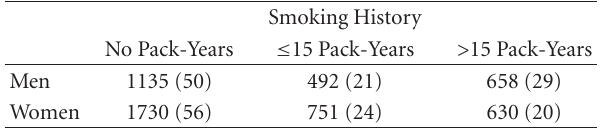
Table 2: Self-reported smoking history among men and women with colonoscopy in the New Hampshire Colonoscopy Registry from